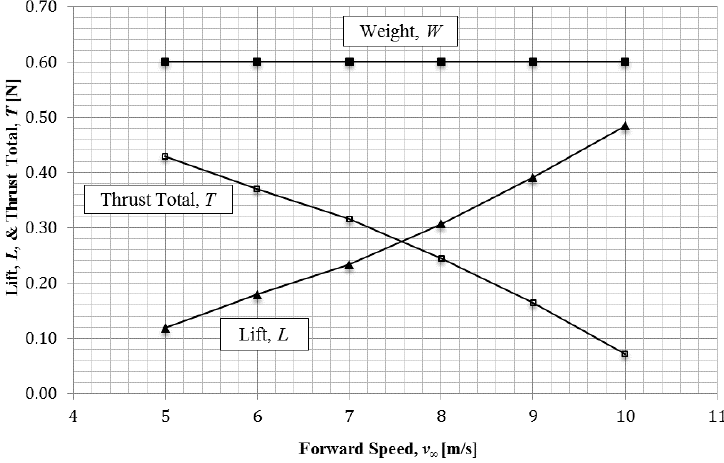
Figure 5. The replication hypothesis assumes the lift, thrust, and weight curves from a bird to apply also to a protobird. The crossover occurs at a forward speed v ∞ of ≈ 7.5 m/s experienced by both